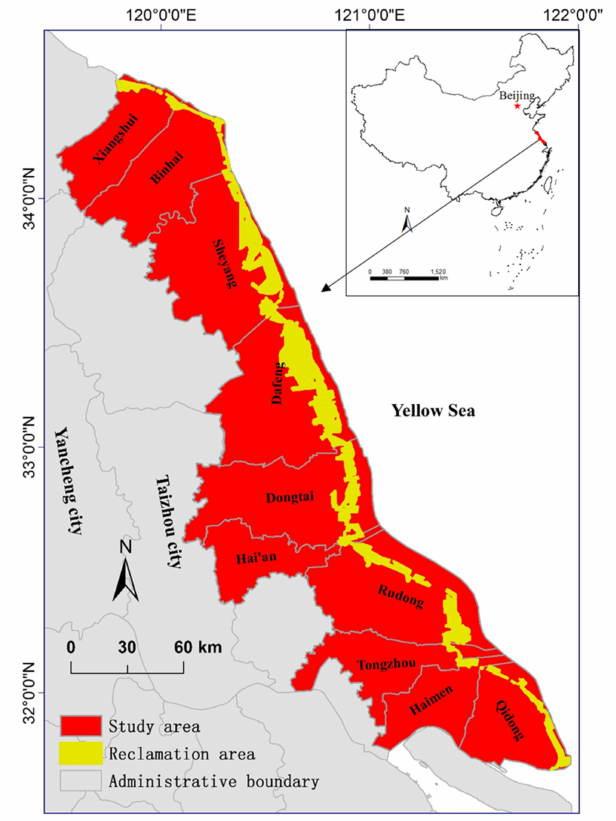
Figure 1. Location of the study area and geographic distribution of reclamation area since